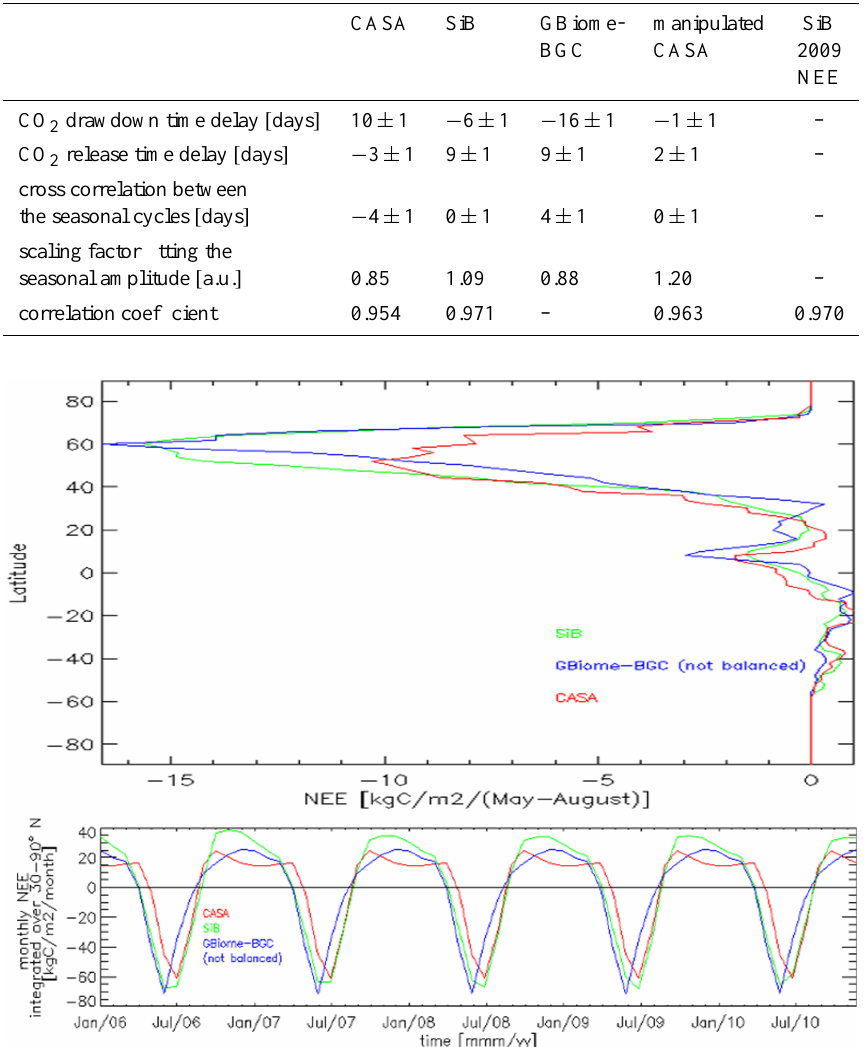
Fig. 1. Upper panel: latitudinal NEE distributions integrated for May until August. The sink between 45 ◦ and 65 ◦ N reflects the CO 2 uptake in the boreal forest in all three models and the biggest differences between the models are found here as well. CASA has a less distinct sink than SiB and GBiome-BGC. Bottom panel: the time series of monthly NEE integrated between 30–90 ◦ N. The SiB NEE estimates include dynamical fluxes while the CASA and GBiome-BGC fluxes used here are